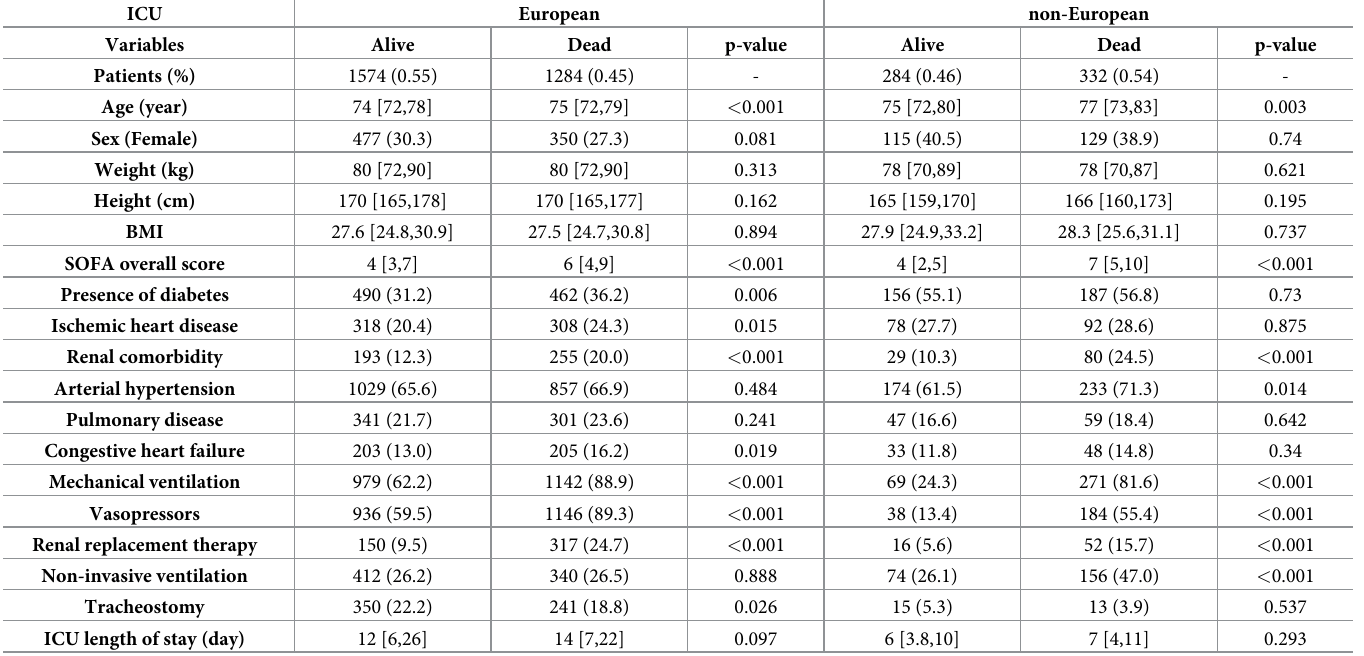
Table 1. Patient characteristics of the European and the non-European cohort, based on ICU mortality outcome. Patient characteristics for the two other outcomes of interest, namely 30-day mortality and early identification of patients at low risk of deterioration are available in Tables A and B in S7 Text respectively.